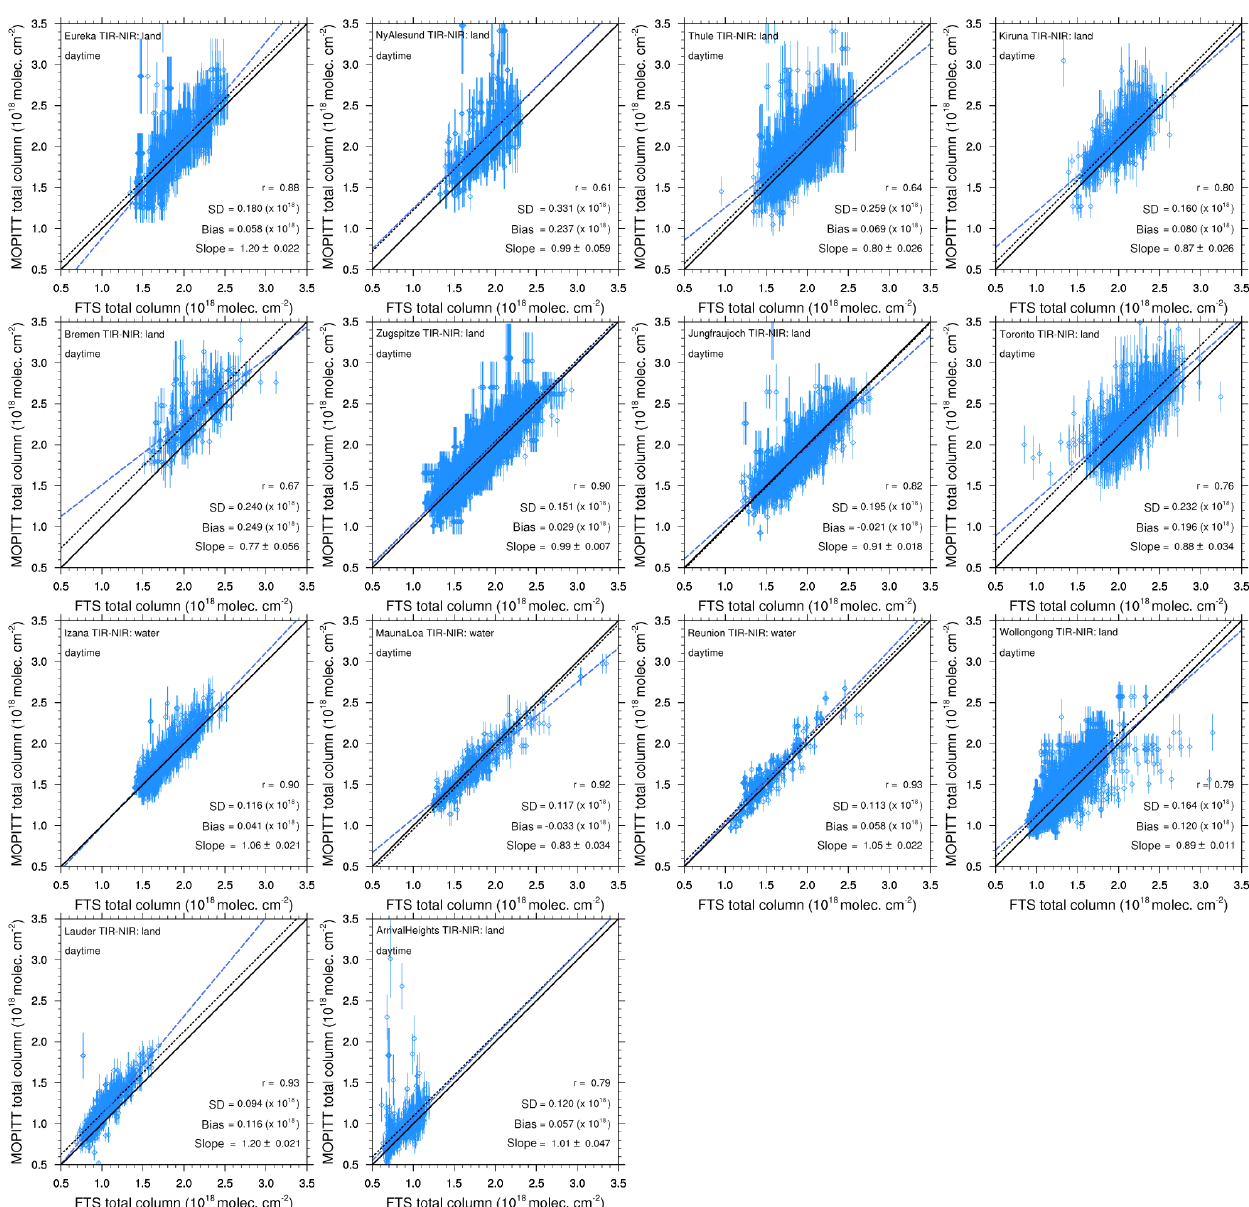
Figure A3. Correlation plot for V6 TIR–NIR product. The blue dashed line indicates correlation slope, the black dashed line indicates mean bias, and the solid black line is the 1 : 1 line for comparison. Error bars are the daily combined MOPITT error within a 1 ◦